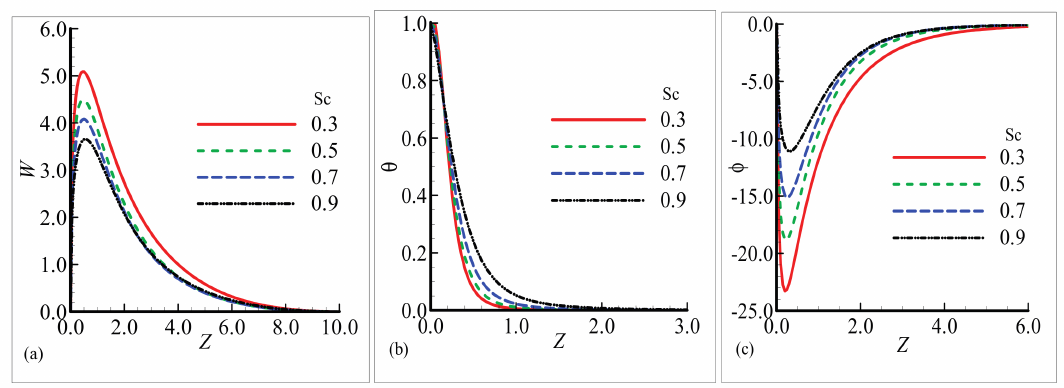
Figure 10. Physical e ff ects on quantities ( a ) u , ( b ) θ , and ( c ) ϕ versus, Sc , when Nt = 0.5, Nb = 0.4, Pr = 0.71, M = 0.5, Q = 0.4.